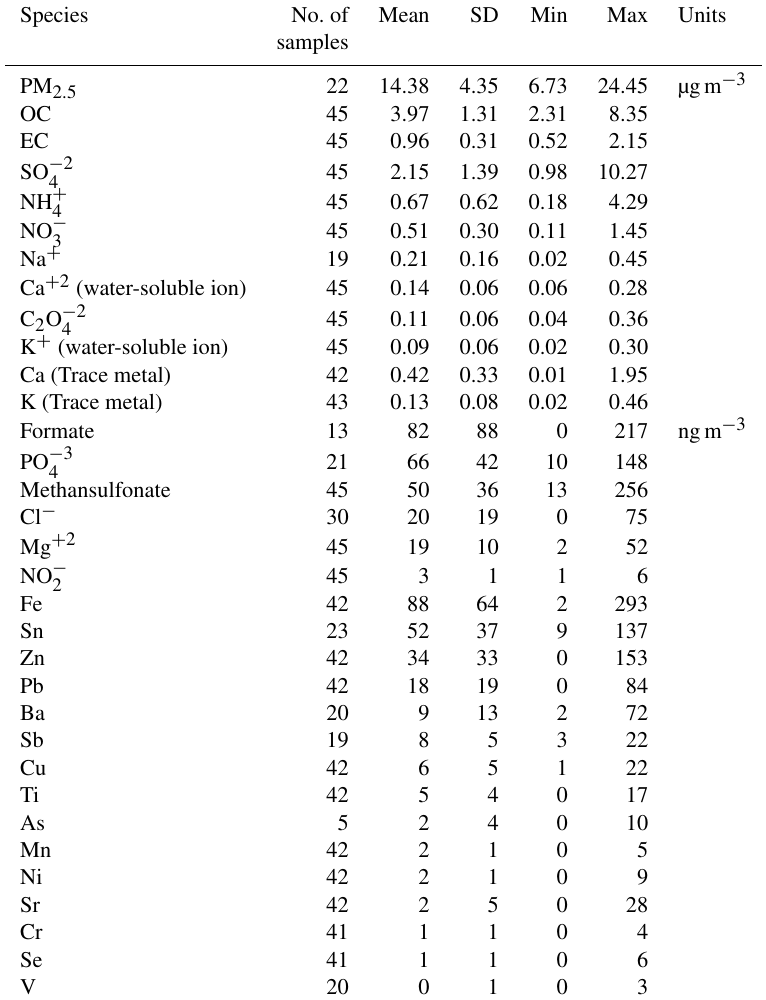
Table 3. Mean, 1SD (standard deviation), minimum and maximum concentrations of carbonaceous fraction, soluble ions, and metals in samples of PM 2 . 5 collected in